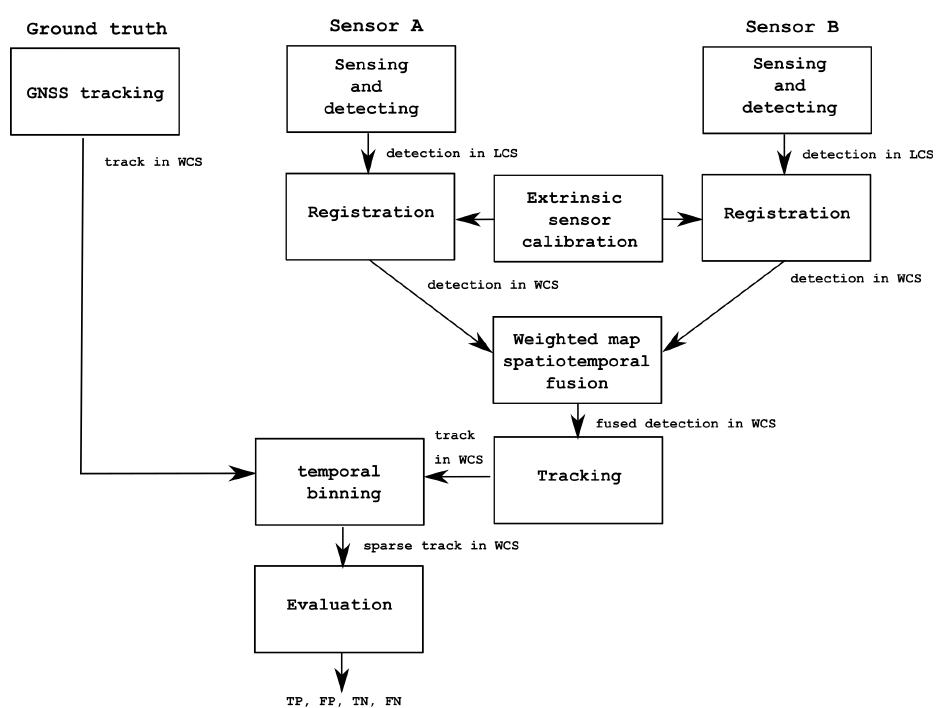
Figure 6. Schematic of data processing for multi fusion approach from detection to fusion to transfor- mation between local coordinate system (LCS) to world coordinate system (WCS) and